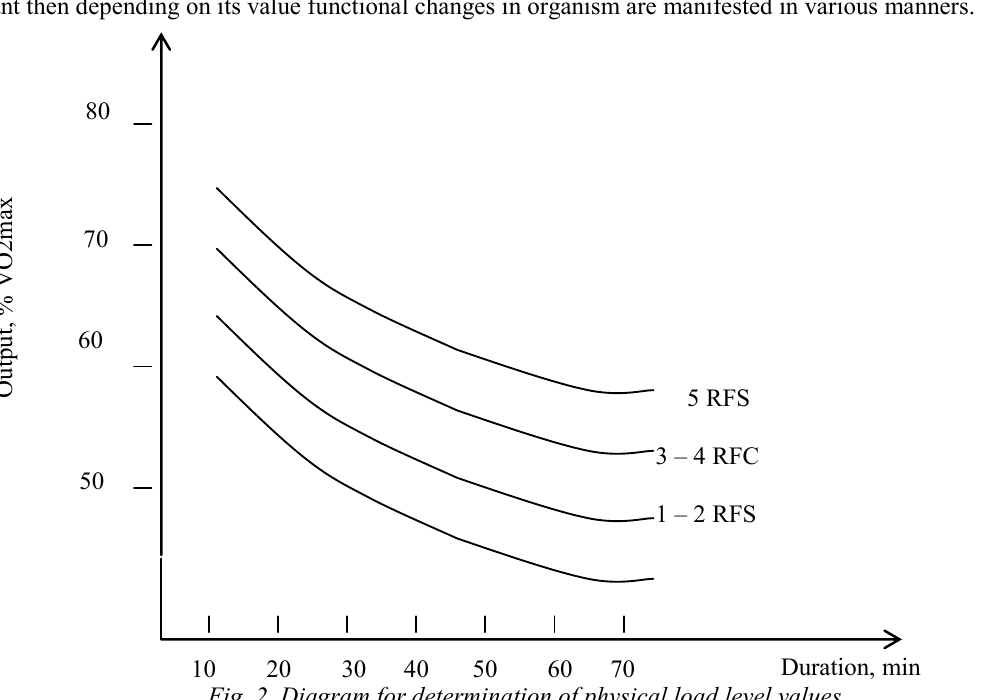
Fig. 2. Diagram for determination of physical load level